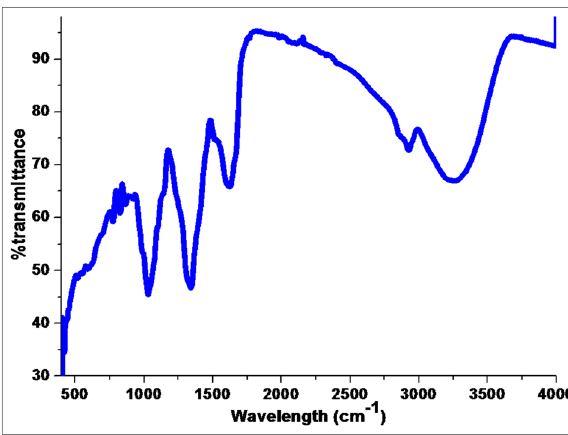
Figure 5: FTIR spectra of synthesized